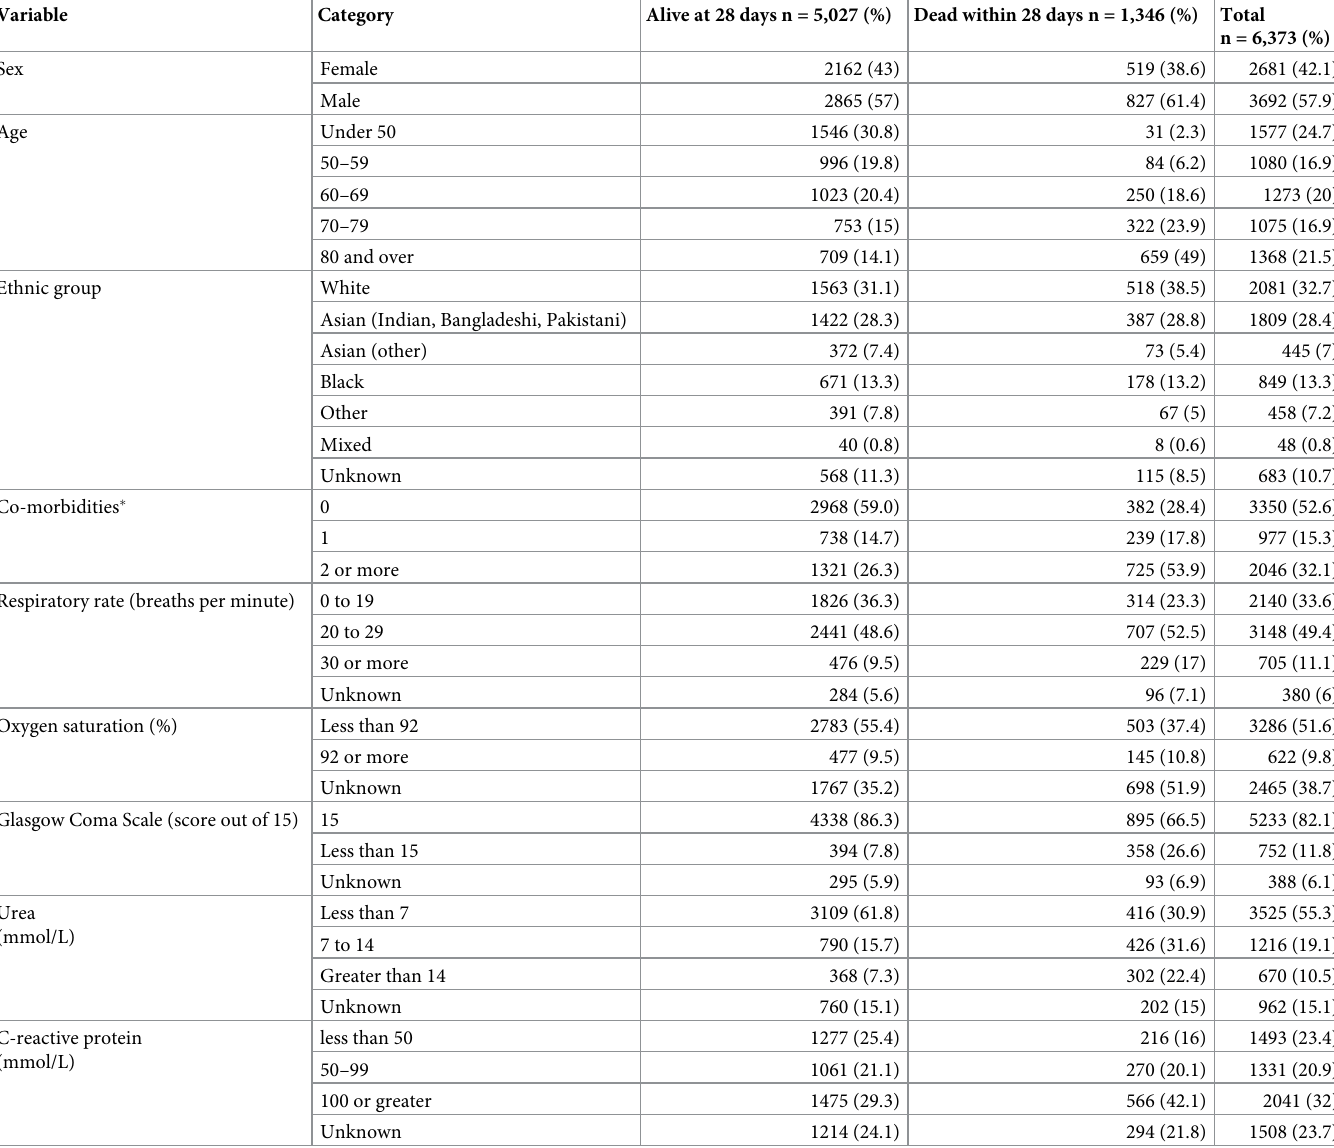
Table 2. A table showing the demographic and clinical characteristics of all included patients at admission, and divided by mortality status at 28 days, including all components of the ISARIC 4C score as well as ethnic group.